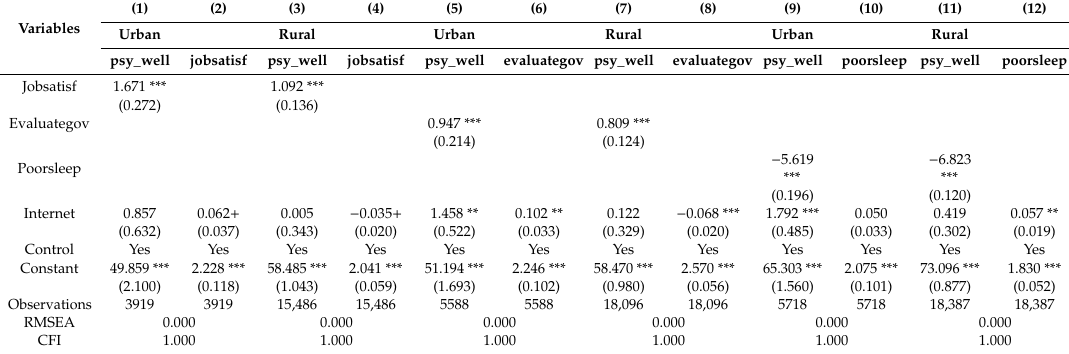
Table 5. Mechanism analysis (2) of the di ff erent e ff ects of the Internet on the two categories of hukou